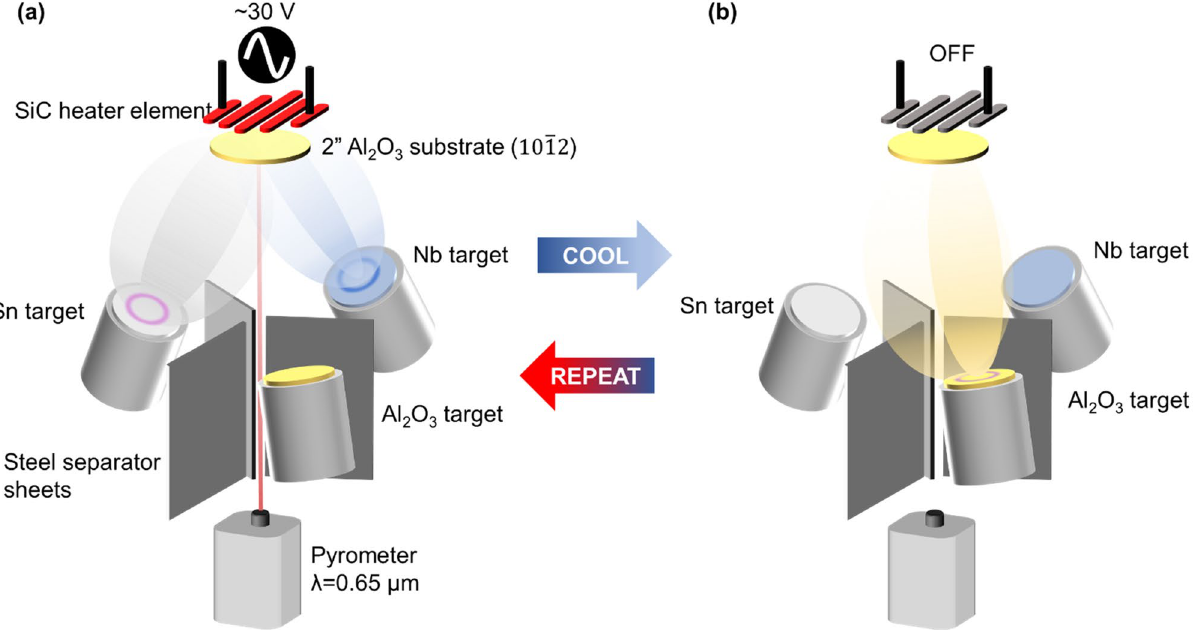
Figure 3. Schematic of thin films deposition setup and sequential processing steps for Nb 3 Sn/Al 2 O 3 multilayer heterostructures. ( a ) Nb and Sn are sputtered onto Al 2 O 3 substrate while heater element is powered on. ( b ) After allowing film to cool, Al 2 O 3 is sputtered from a single stoichiometric Al 2 O 3 target. Sample is heated again to anneal Al 2 O 3 . These two steps are repeated to produce multilayer samples.